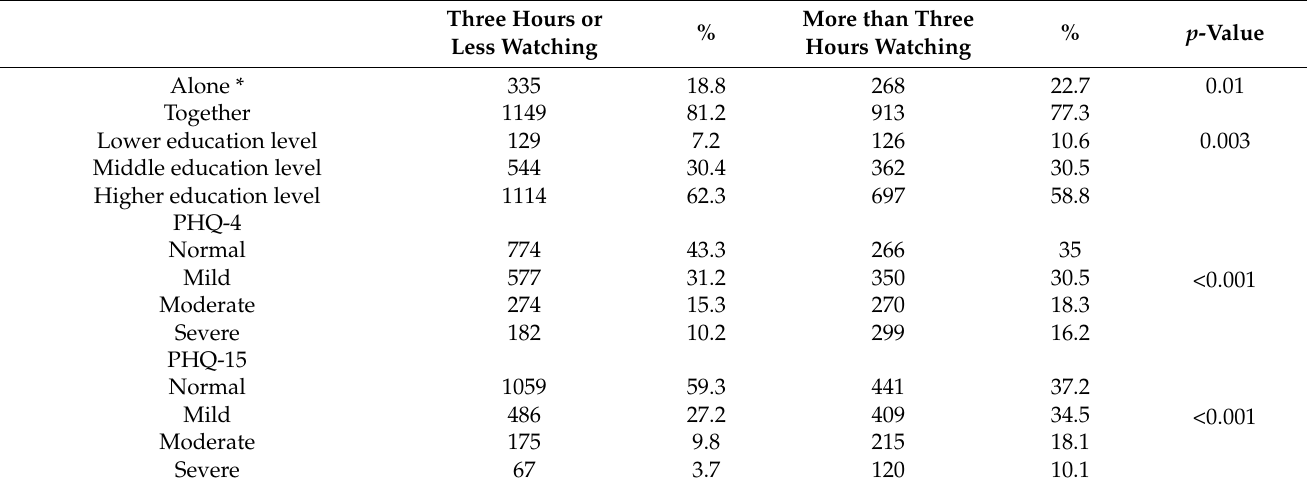
Table 3. Media watching, living conditions and education